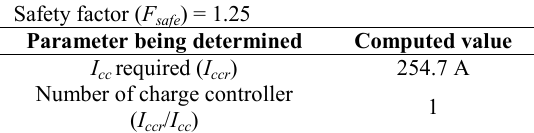
Table 9. Orientation parameters selected in PVsyst.